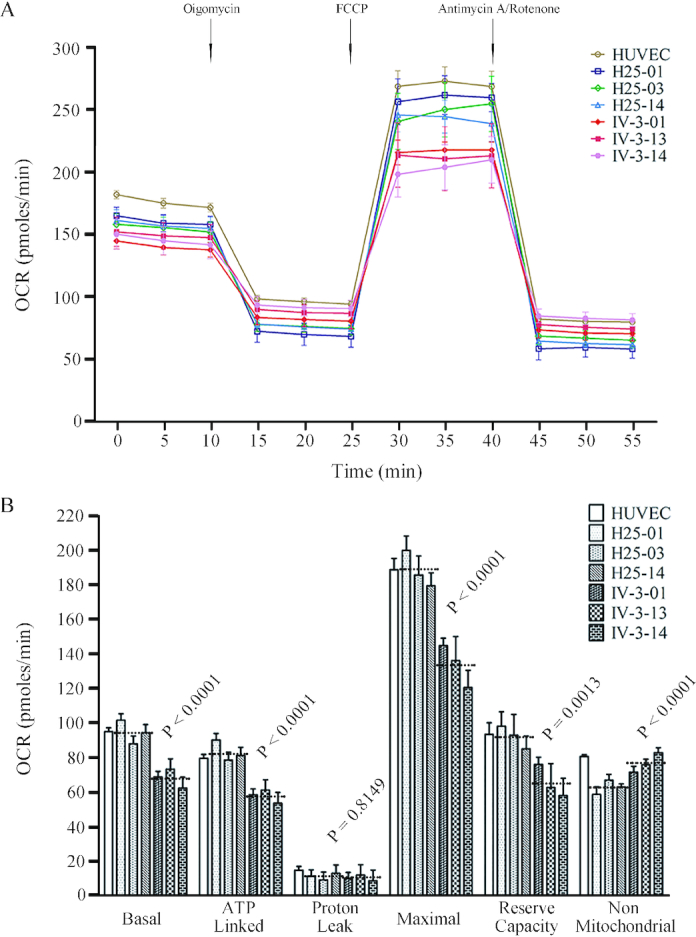
Respiration assays. (A) Analysis of O2 consumption in the various cell lines using different inhibitors. The rates of oxygen consumption (OCR) were first measured on 2 × 104 cells of each cell line under basal conditions and then with sequential additions of oligomycin (1.5 μM), FCCP (0.8 μM), rotenone (3.0 μM), and antimycin A (1.5 μM) at the indicated times to determine different parameters of mitochondrial functions. (B) Graphs presented the basal OCR, ATP-linked OCR, proton leak OCR, maximal OCR, reserve capacity OCR and non-mitochondrial OCR in HUVEC, mutant and control cybrid cell lines. Basal OCR was determined as OCR before oligomycin minus OCR after rotenone/antimycin A. ATP-linked OCR was determined as OCR before oligomycin minus OCR after oligomycin. Proton leak OCR was determined as basal OCR minus ATP-linked OCR. Maximal OCR was determined as the OCR after FCCP minus non-mitochondrial OCR. Reserve capacity OCR was defined as the difference between maximal OCR after FCCP minus basal OCR. Non-mitochondrial OCR was determined as the OCR after rotenone/antimycin A treatment. The average of 6 determinations for each cell line is shown. Graph details and symbols are explained in the legend to Figure 3.